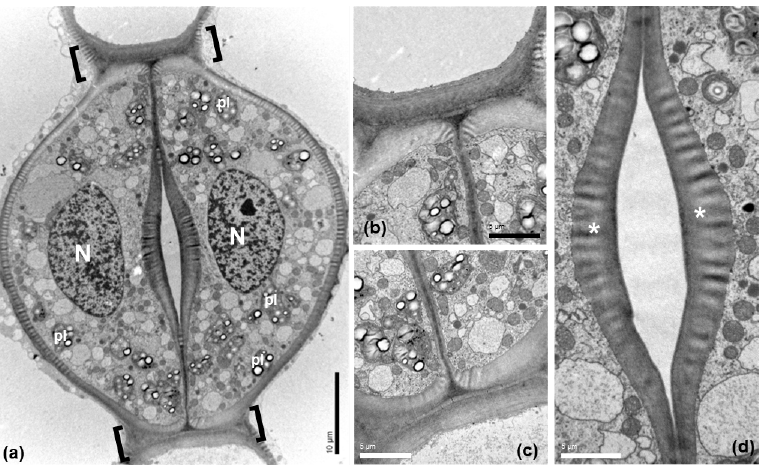
Figure 3. Transmission electron microscopy (TEM) depicting a stoma of Pancratium maritimum leaf at paradermal section. ( a ) Low magnification presenting guard cell fine structure. ( b , c ). The transverse cell wall ends, defined by brackets in (a ), are thickened. ( d ) Ventral walls are thickened at the site of the stomatal pore. Note the non-uniform electron density of the thickenings at the areas denoted by asterisks. N: nucleus, pl: plastid. Scale bars as depicted on image.